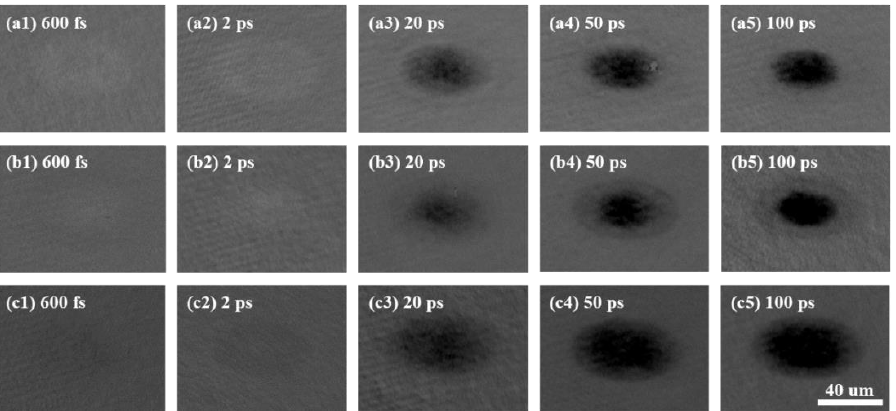
Figure 2. Time-resolved reflectivity of the excited areas on pure GST and different nitrogen content GST films by a single femtosecond laser pulse with a fluence of 0.034 J/cm 2 . ( a1 – a5 ) Images of time-resolved reflectivity of pure GST films, ( b1 – b5 ) Images of time-resolved reflectivity of 2:1 films, ( c1 – c5 ) Images of time-resolved reflectivity of 2:2